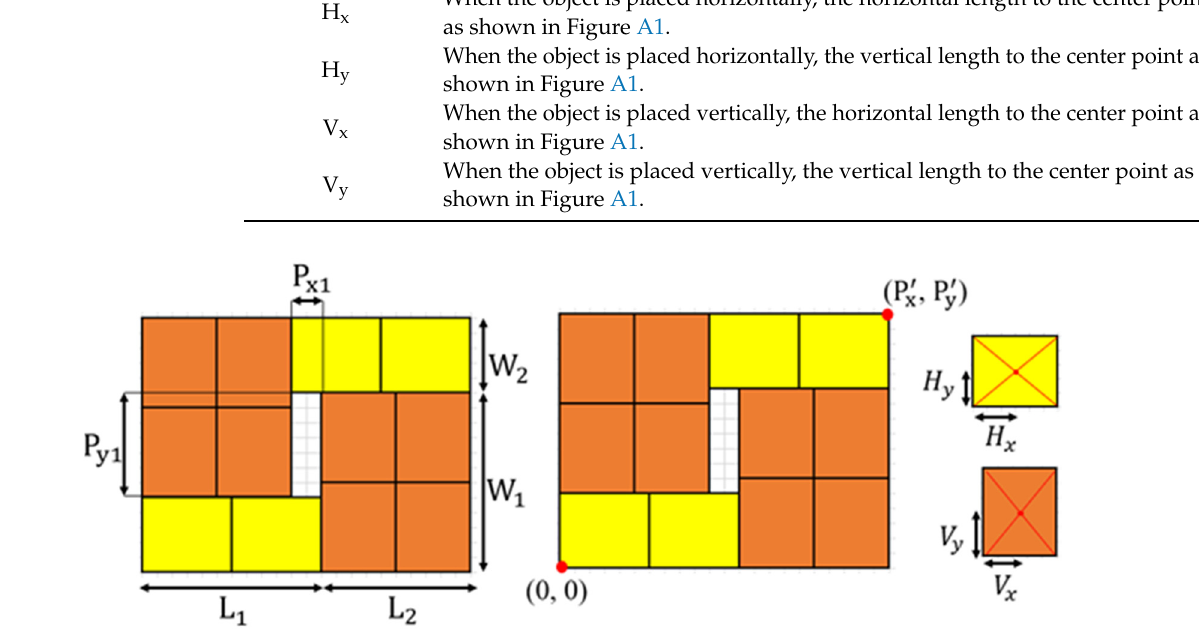
Figure A1. Schematic diagram of object.